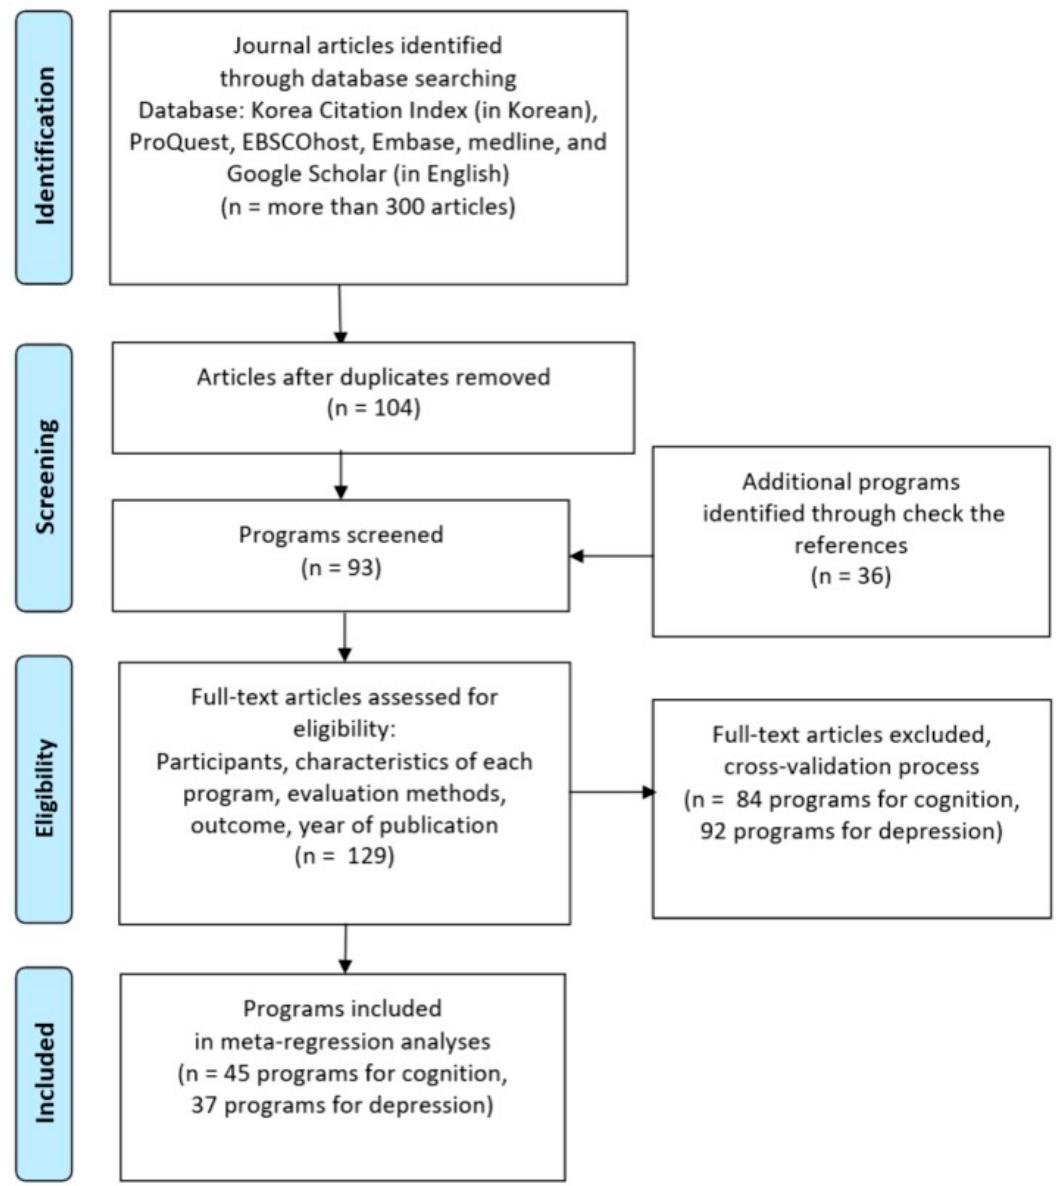
Figure 1. Flow diagram: Data collection and selection process.